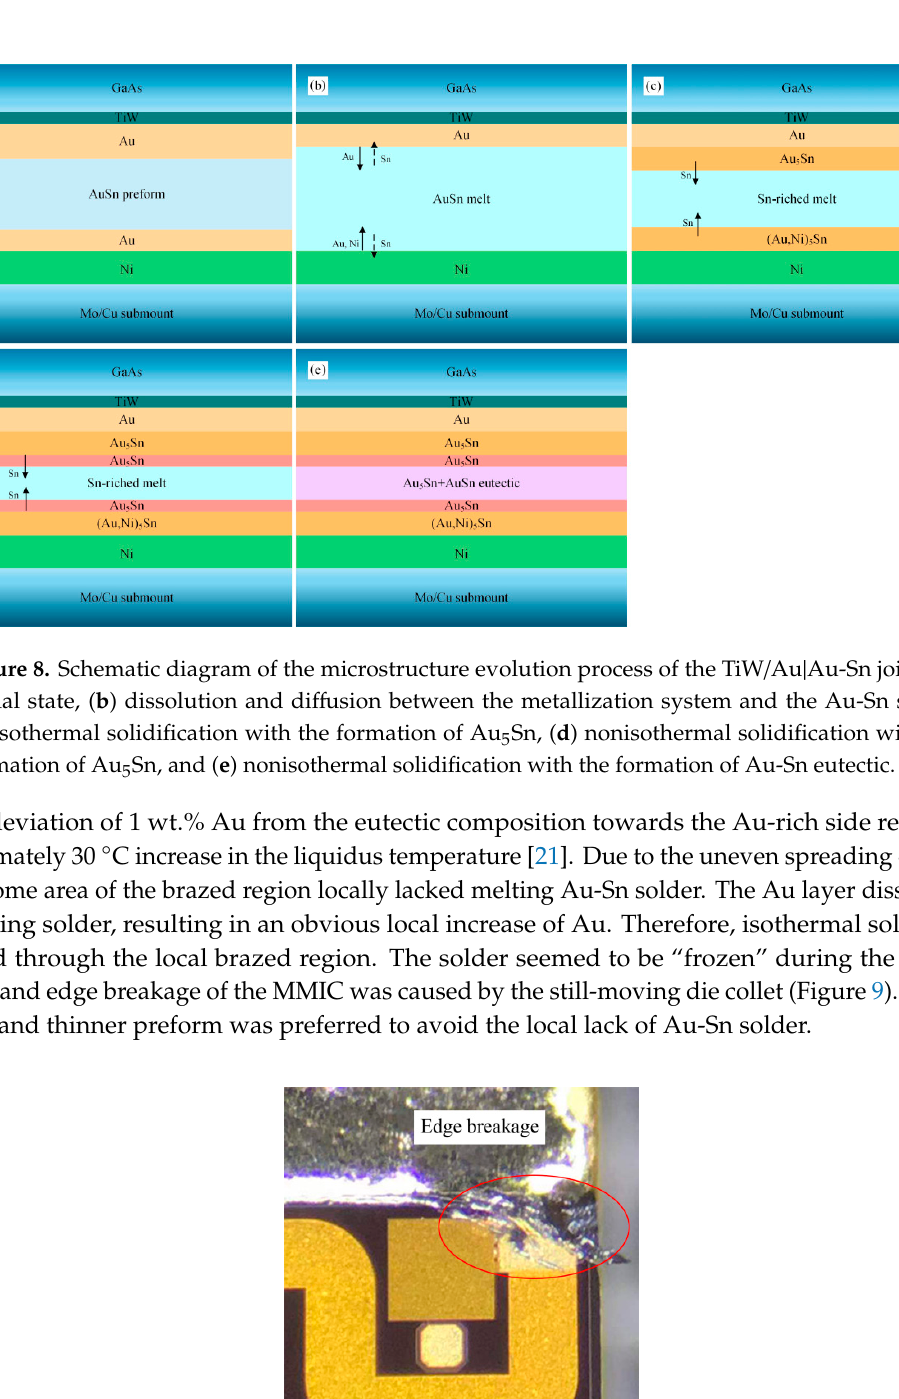
Figure 9. Edge breakage of GaAs MMIC in the TiW/Au|Au-Sn eutectic joint.